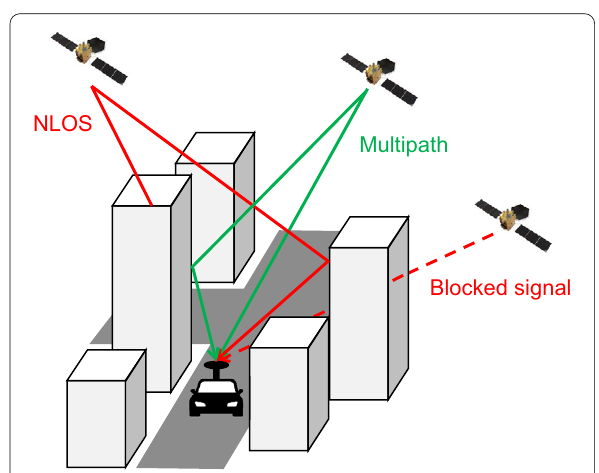
Fig. 11 Multipath, NLOS and blocked signals in city